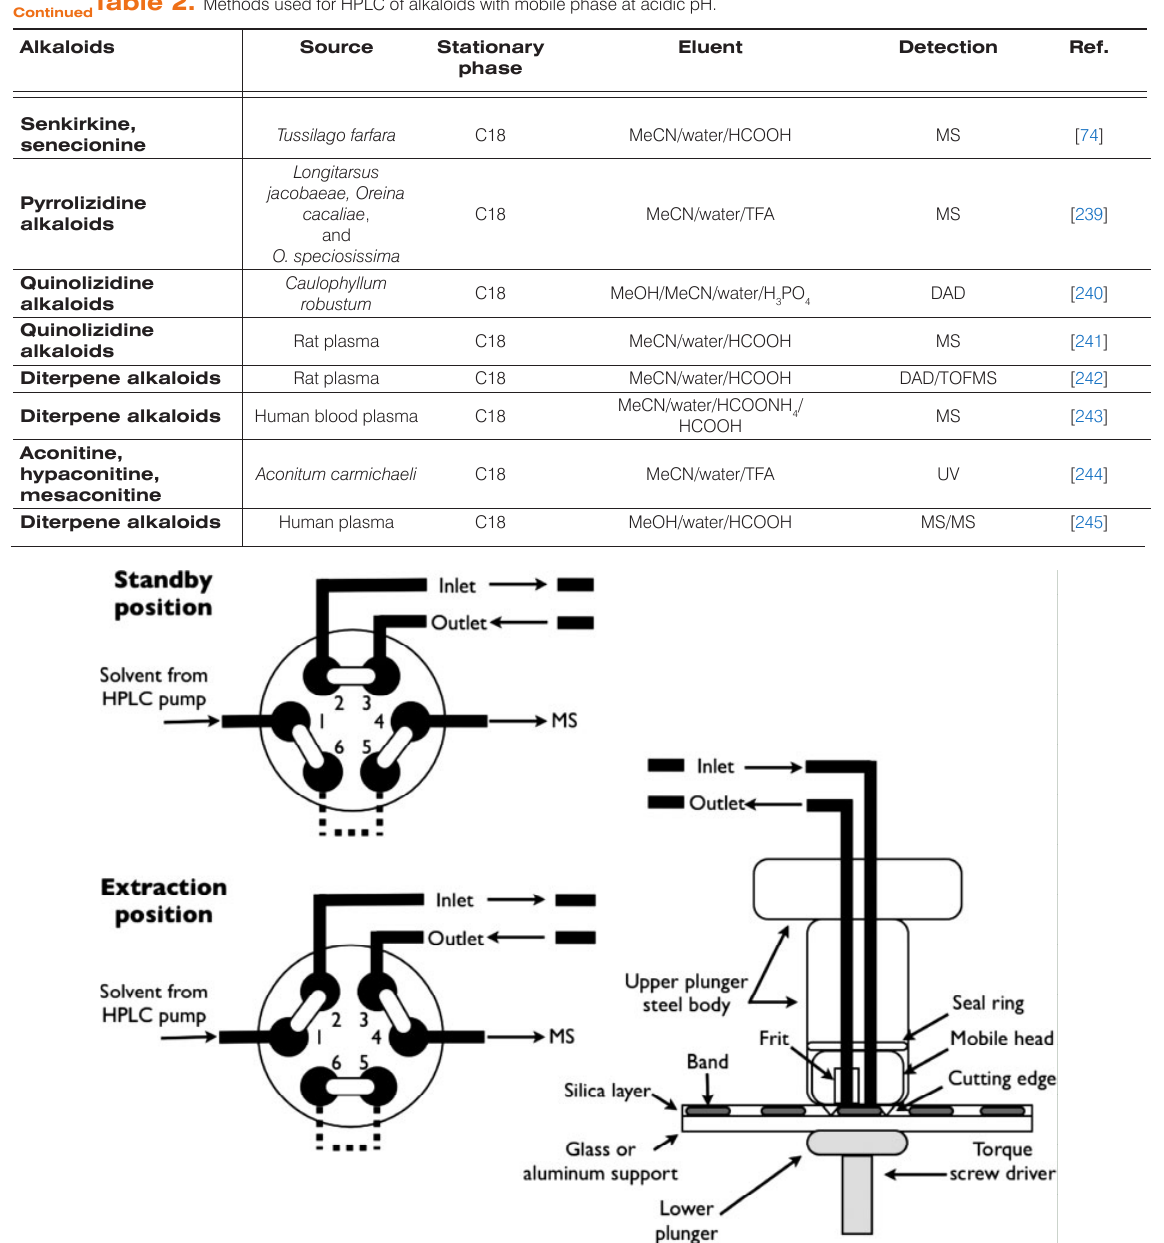
Figure 6. Schematic diagram of the interface components and the two positions of the six-port valve TLC/ESI-MS